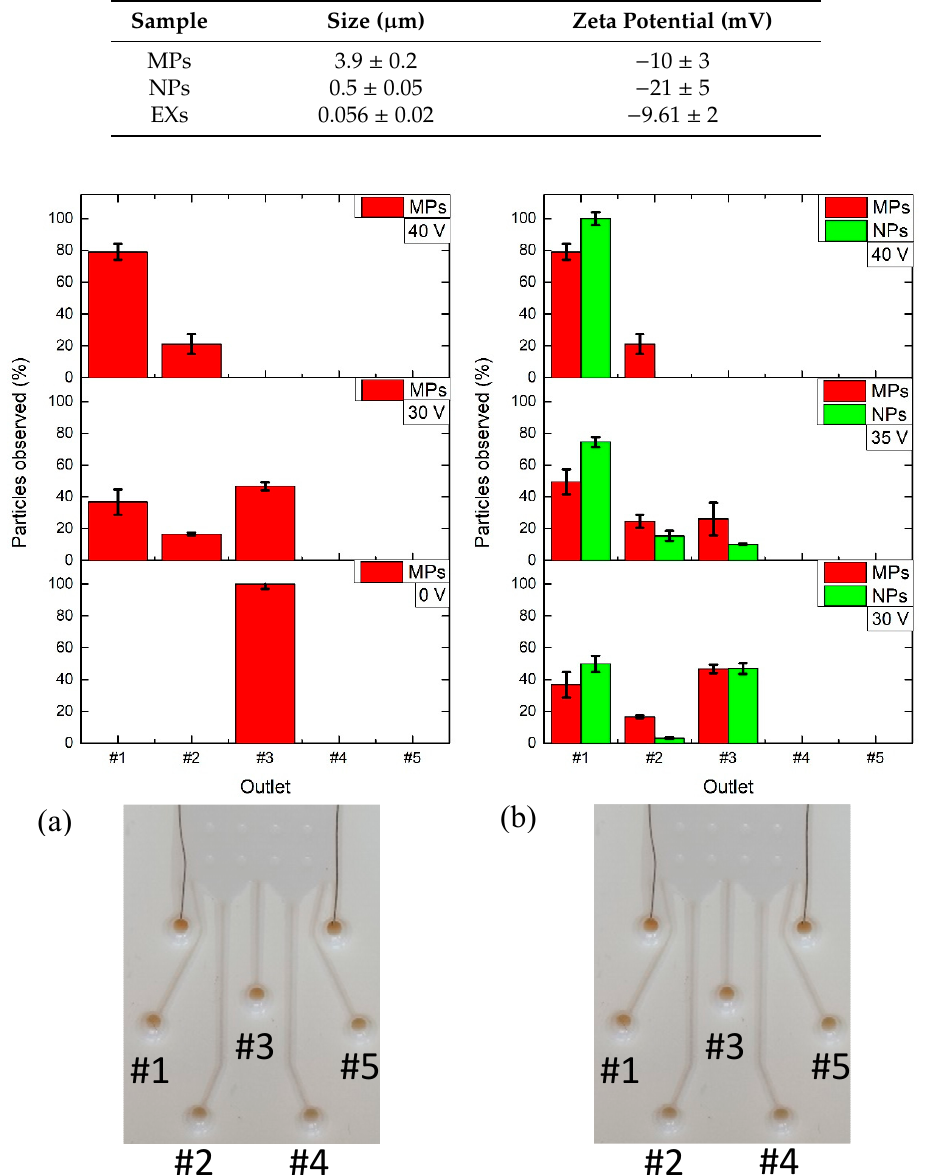
Figure 6. Micro- and nanoparticle (M/NP) collections at the outlets of the glossy µFFE device by setting a buffer flow rate of 20 µL/min and an analyte flow rate of 10 µL/min for 10 min: ( a ) MP outlet collection for Δ V = 0, 30, 40V, ( b ) M/NP outlet collection for Δ V = 30, 35, 40V. A percentage of particles observed, 100% and 79%, for MPs and for NPs, respectively, was obtained at Δ V = 40V. The corresponding outlets are reported in the inset for both ( a ) and ( b ).